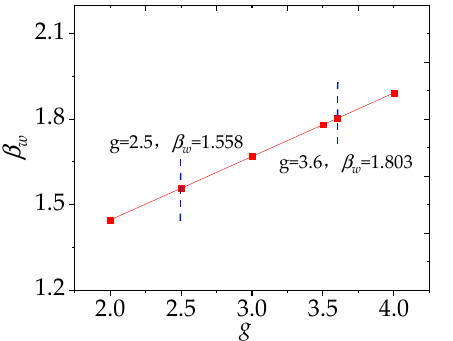
Figure 9. Variation curve of the weighted wind-induced vibration coefficient with